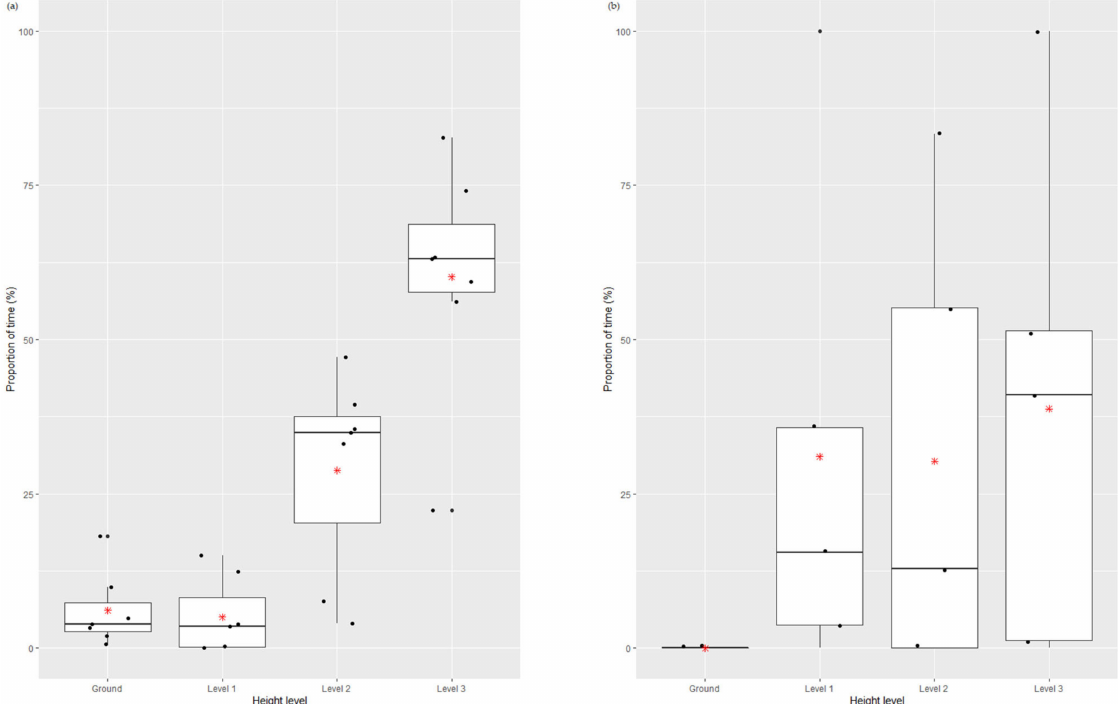
Figure 2. Proportion of time (%) the ( a ) male study subject and ( b ) female study subject spent at different height levels whilst in the indoor habitat. Height use data displayed using boxplots outlining the first quartile, median, third quartile and range of the data. Jitter plots used to visualize each collected data point represented by black circles. Red star denotes the mean value of time spent utilizing each